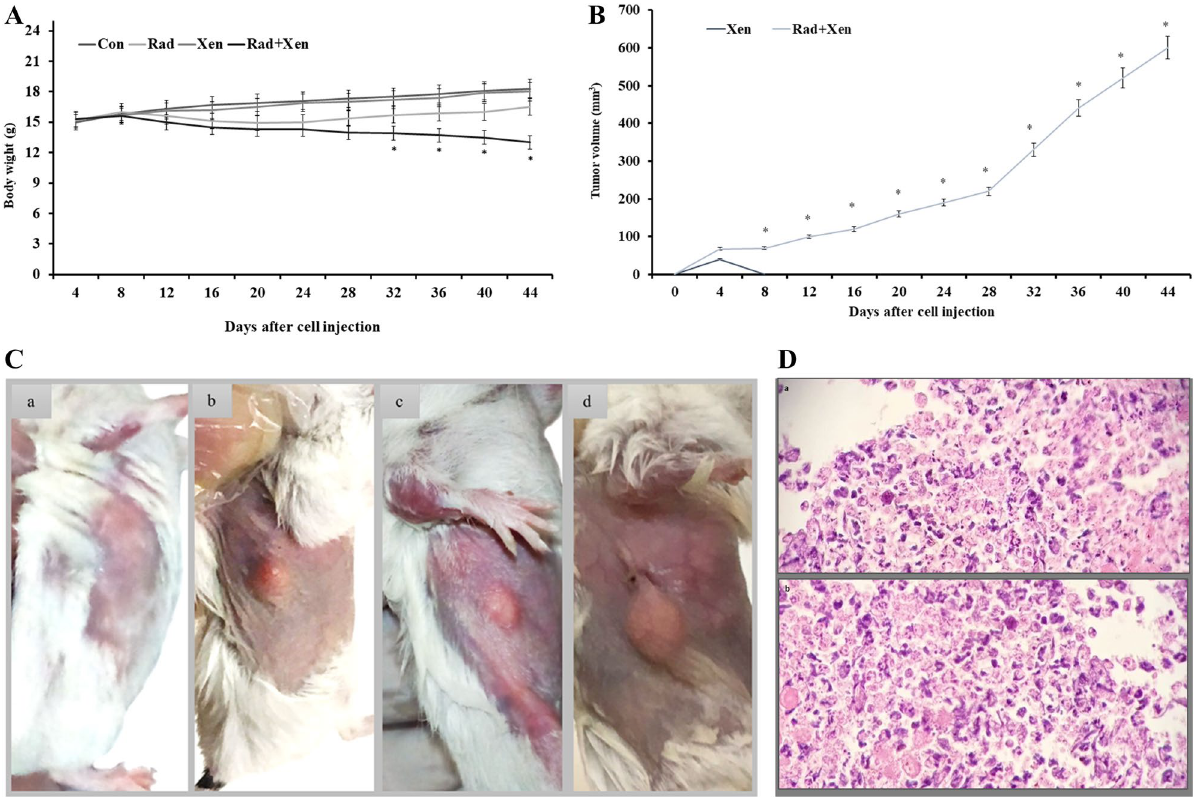
Figure 1. The macroscopic views of (A) the body weight, (B) the tumor volume, and (C) the tumor extension on days 10 (a), 20 (b), 30 (c), and 40 (d) after the gamma radiation in mice, and (D) the microscopic views of the xenograft breast tumor (× 20). Con: control, Xen: cell injection group, Rad: gamma radiation group, and Xen + Rad: gamma radiation plus cell injection group. Data were reported as mean ± SD. * P ≤ 0.05 compared to the Xen